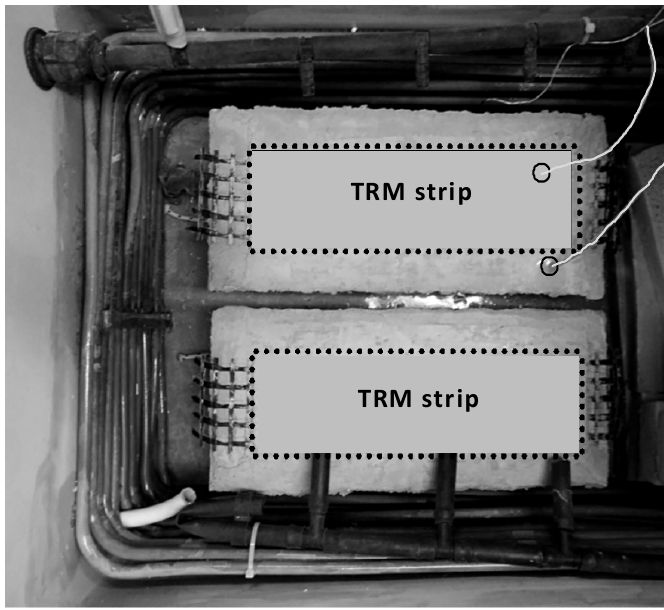
Figure 3. Two identical specimens inside the freeze–thaw chamber.